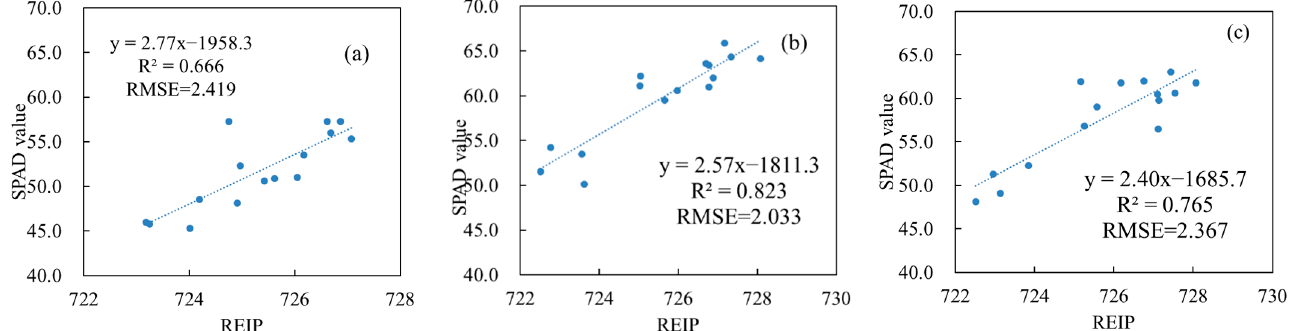
Figure 7. Relationship between SPAD values at different layers and the REIP index under the optimum VZA in the early growth stage: ( a ) 1st layer, ( b ) 2nd layer, and ( c ) 3rd layer.